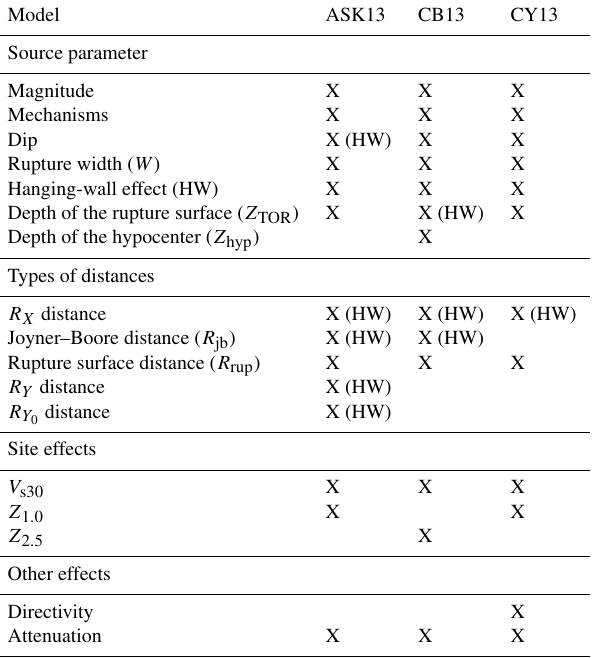
Table 2. Parameters considered by the selected strong movement models.